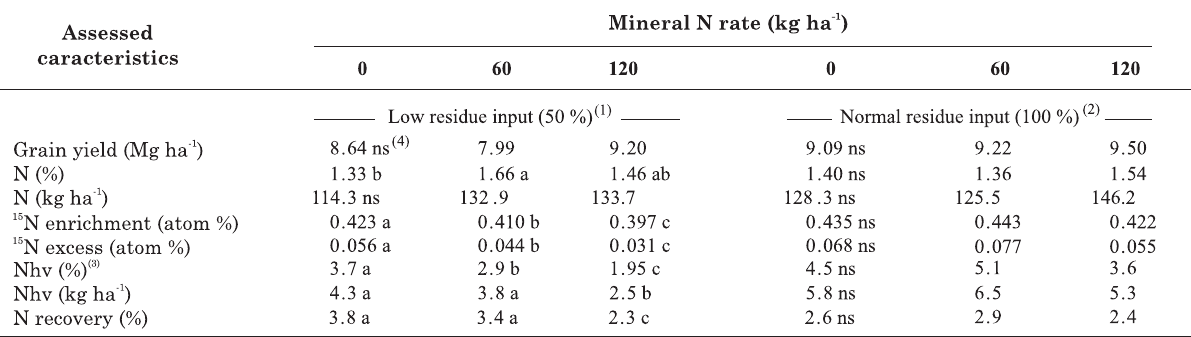
(1) Low residue input = 50% of the hairy vetch dry matter production, residues were not labeled in 2004. (2) Normal residue input = 100% of the hairy vetch dry matter production, residues were not labeled in 2004. (3) Nhv = hairy vetch-derived N. (4) Values followed by the same letter at the same residue level and in the same evaluation year were not significantly different by Duncan’s test (p ≤ 0.05).